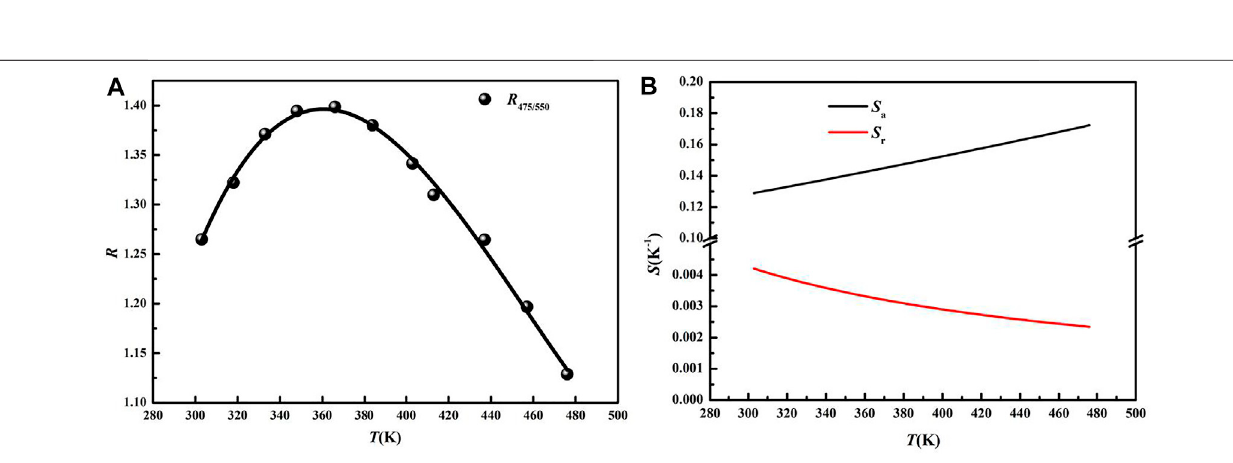
Frontiers in Materials |